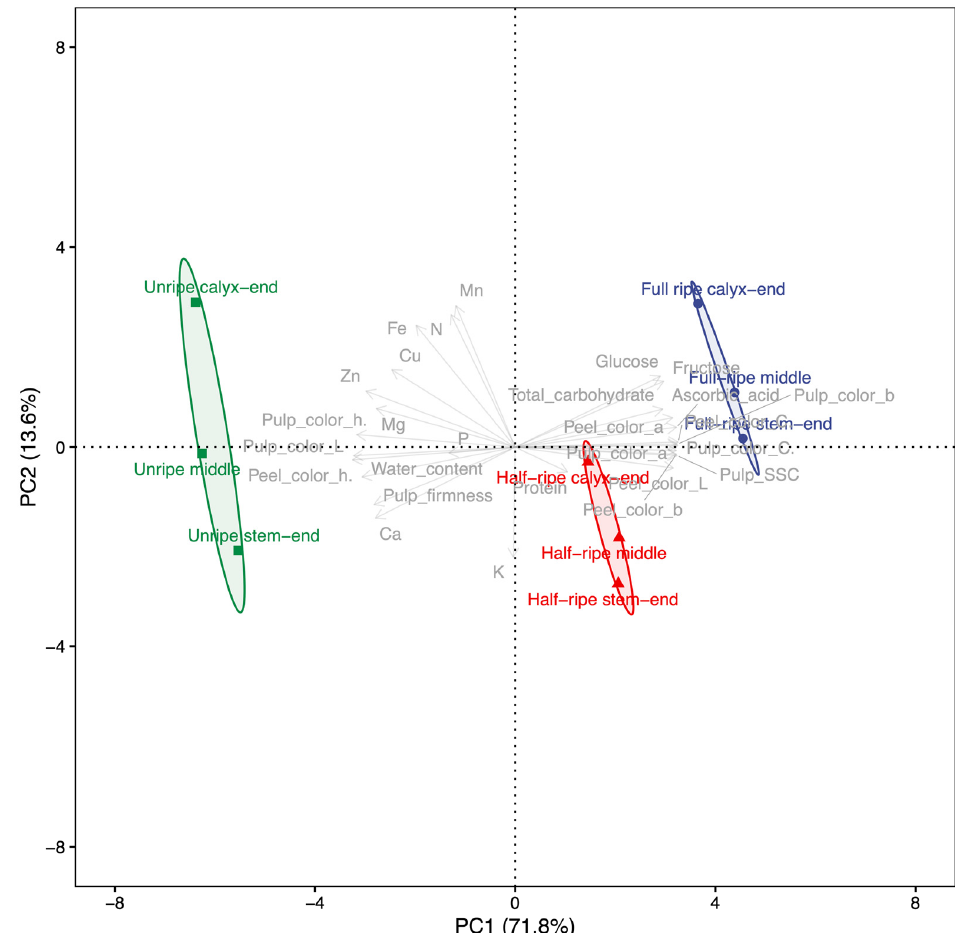
Figure 2. Principal component (PC) analysis scores of fruit qualities with PC scores of means on the first 2 PC axes for “Tainung No. 2” Red papaya ( Carica papaya ) at 3 parts across ripening stages with 95% confidence of ellipses for the mean of ripening stages. Percentages in parenthesis of each axis represent variances of each PC. Green—unripe at 16 weeks after anthesis (WAA); red—half-ripe at 18 WAA; blue—full-ripe at 20 WAA.